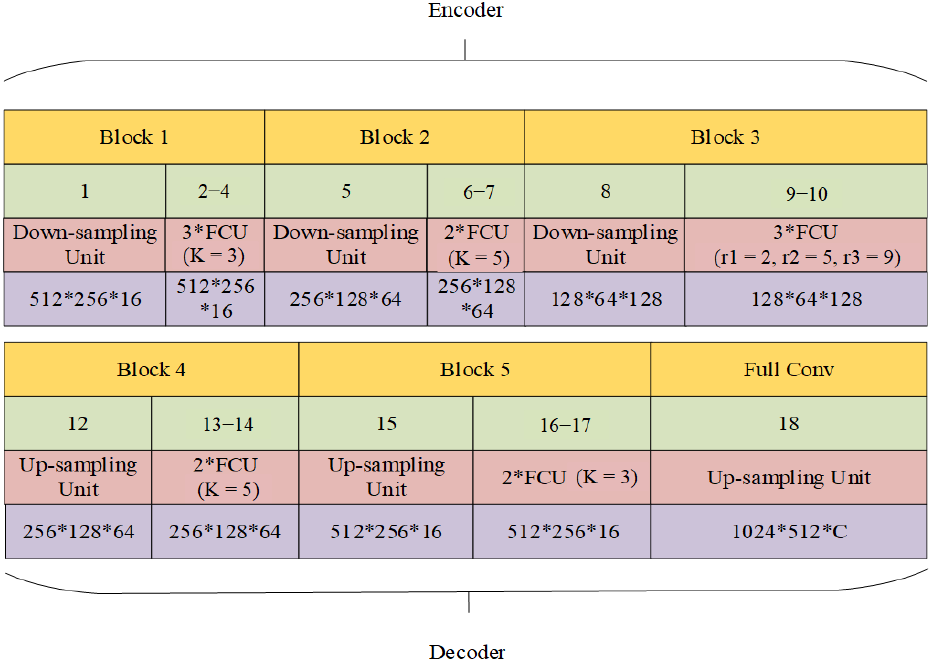
Relu BN Figure 8. The structure of PFCU. The specific structures of the bottleneck residual block, non-bottleneck residual block, one-dimensional non-bottleneck residual block and FCU in ResNet are shown in Figure 9.